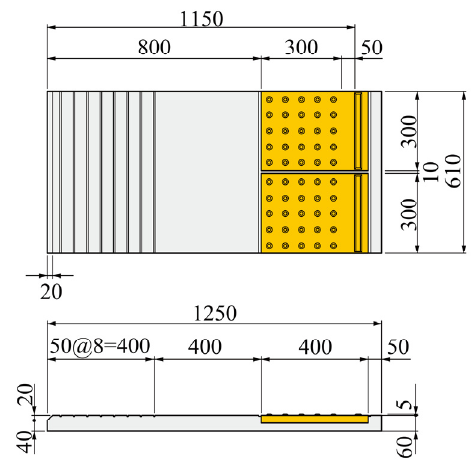
Figure 15. Platform edge coping with tactile